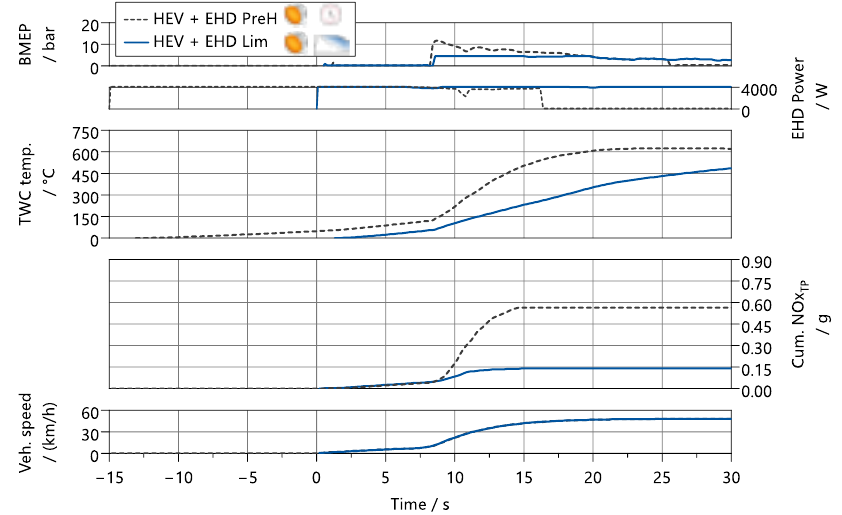
Figure 12. Start of the High Altitude cycle with EHD combined with pre-heating and power